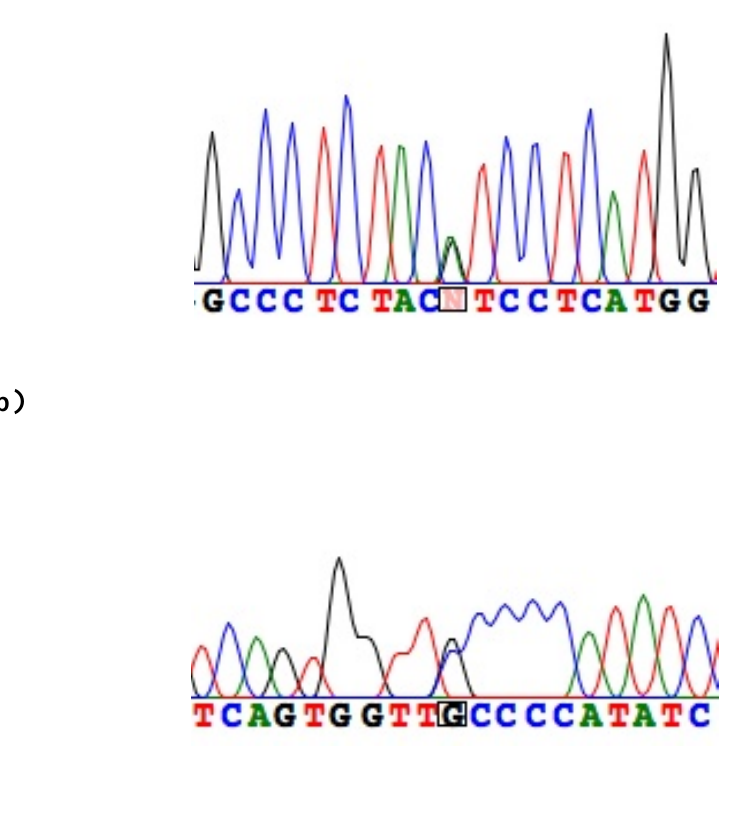
Figure 2. Chromatograms of the newly identified KCNE1 Val47Ile (a) and noncoding C>G substitution in the 3'UTR (b)